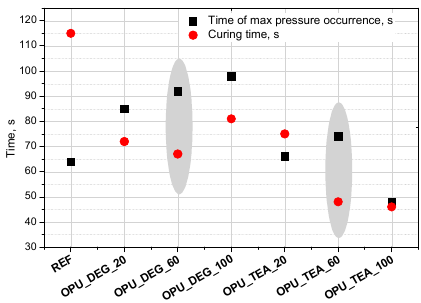
Figure 5. Time of max pressure occurrence and curing time of polyurethane (PUR) systems.